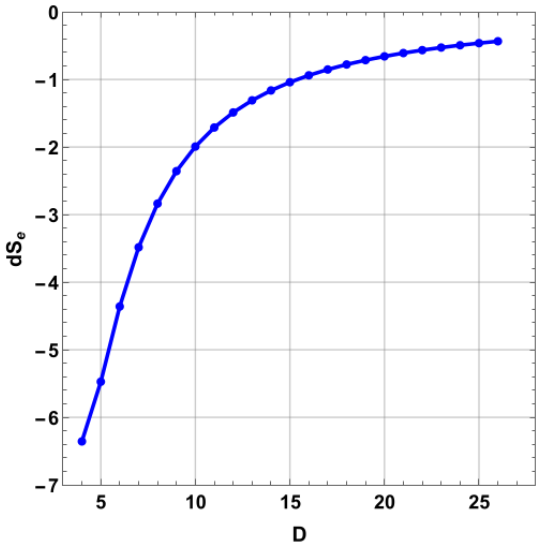
Figure 2. Variation of entropy dS e for the extrema black hole as a function of spacetime dimension D , with | p r | = 1 , Q = 1 , l = 1 and dQ = 0 . 1 h